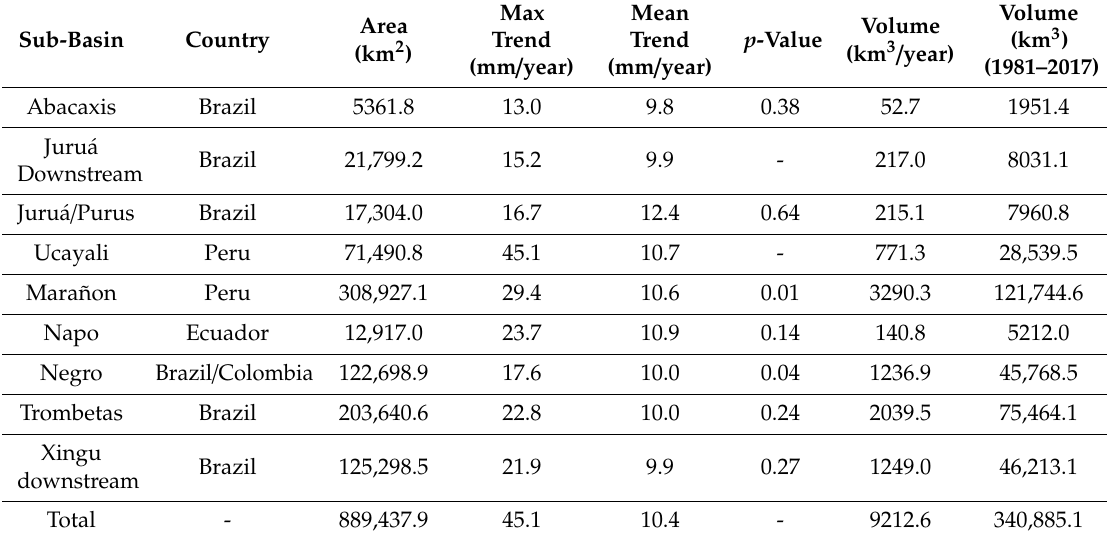
Table 3. Clusters with positive